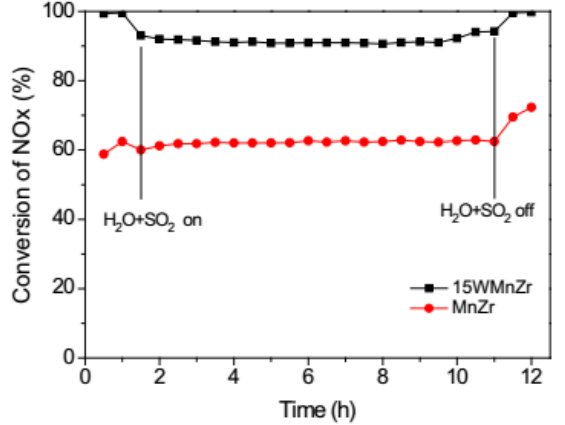
Figure 17. Response of NO x conversion over MnZr and 15WMnZr catalysts at 300 °C to intermittent feed of H 2 O and SO 2 (Reaction conditions: [NO] = [NH 3 ] = 500 ppm, [O 2 ] = 5%, [H 2 O] = 5%, [SO 2 ] = 50 ppm, GHSV = 128,000 h − 1 ). (Reproduced with permission from Reference [40], Copyright 2016, Elsevier.)